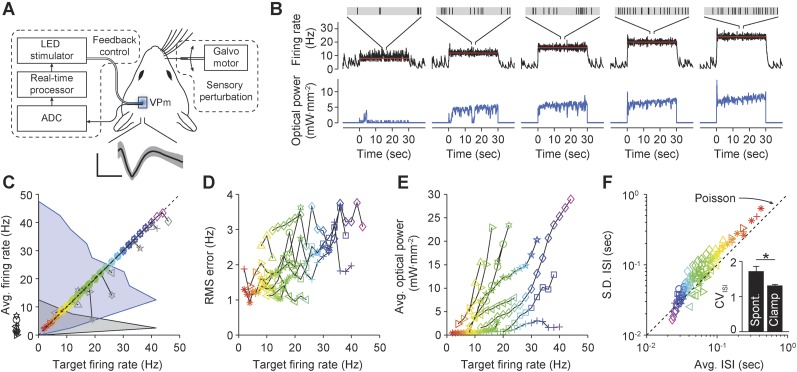
Firing rate control of isolated thalamic units, in vivo.(A) Single unit extracellular recordings were performed in thalamic VPm and used to update the optical power of the LED stimulator. The primary vibrissa could be deflected along the rostral–caudal plane using a galvanometer-based scanning motor to provide sensory perturbations during closed-loop control. A representative TCU waveform is shown (black line is the mean and the shaded region is ± 1 SD). Vertical and horizontal scale bars represent 100 μV and 1 ms, respectively. (B) Single-trial closed-loop firing rate control in the absence of sensory input. Traces show the target firing rate (red), measured firing rate (black), and light power (blue). Inset spike trains display 1 s of activity for each target rate. (C) Time-averaged firing rates vs target rates for 10 TCUs (symbols). Data points are color coded according to the target rate. Black symbols at left indicate spontaneous firing levels prior of closed-loop control. Grey symbols indicate control failure. Data points derived from a single TCU are connected with a line. Shaded areas are peak-normalized histograms of spontaneous firing rates (black) and successfully controlled firing rates (blue) across units. (D) RMS tracking error for each target rate. (E) Average light power required for each target rate. (F) Mean vs standard deviation of the ISI distribution for each target rate. The dotted identity line indicates Poisson firing statistics. Inset bar chart shows the mean CVISI across units during spontaneous and clamped firing. *p = 0.043; t-test.